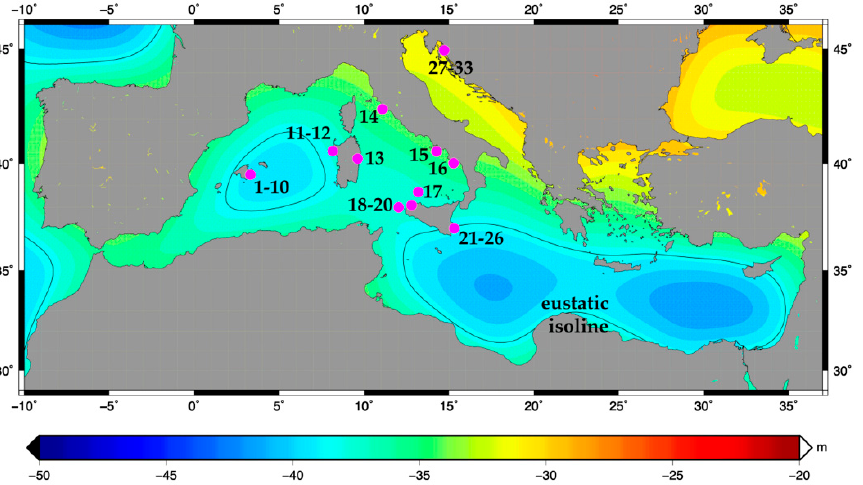
Figure 12. Predicted RSL elevation in the Mediterranean Sea during MIS 5.1 according to ANICE- SELEN and the MVP 3 mantle viscosity profile. The pink dots indicate the location of the sites. The black isoline corresponds to the eustatic value ( − 38.5 m).